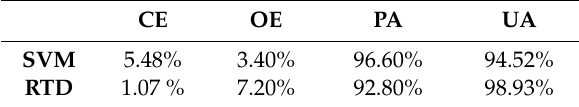
Table 5. The cloud commission error (CE), omission error (OE), producer’s accuracy (PA), and user’s accuracy (UA) of the SVM and RTD methods for the Hainan images.